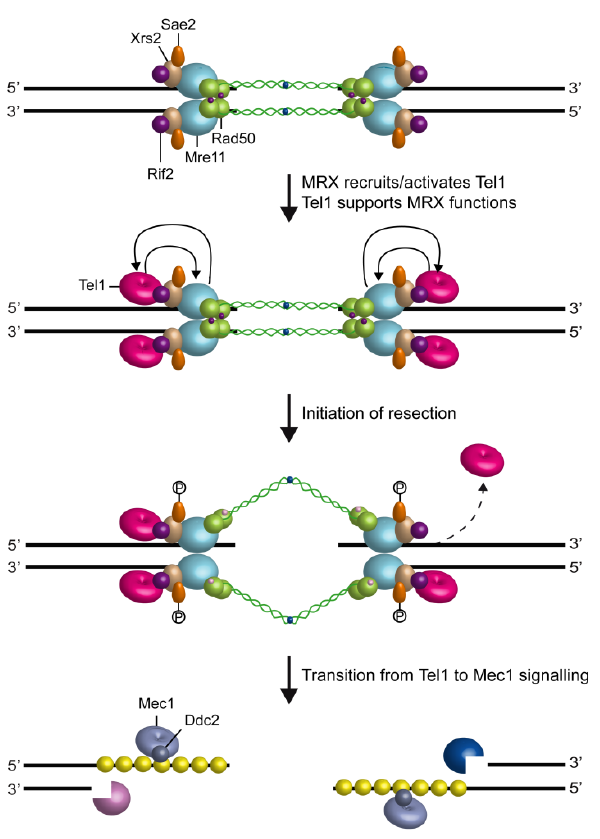
FIGURE 3: Crosstalk between MRX and Tel1. The MRX complex is required to recruit and activate Tel1, which initiates DSB signaling. Tel1, once loaded to the DSB ends by MRX, supports MRX